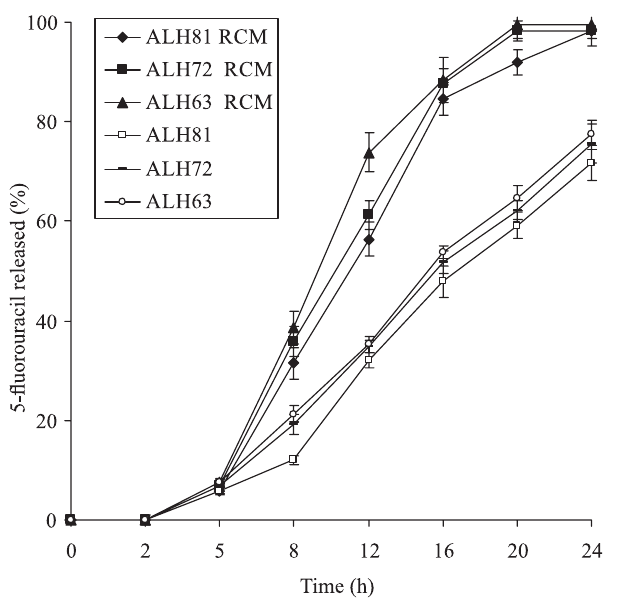
FIGURE 1 - In vitro release profile of 5-fluorouracil from formulation coated with 300 mg without and with rat caecal medium (RCM).